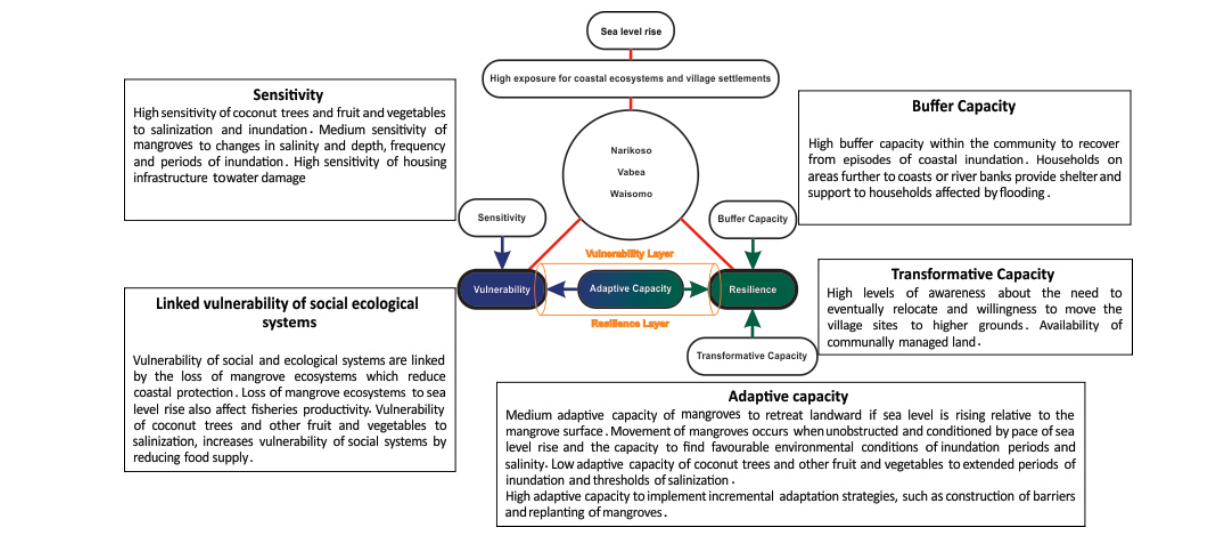
Fig. 5. Drivers of vulnerability and resilience to sea-level rise identified on Ono Island, Fiji. Each component of the model is characterized to identify the different layers of vulnerability and resilience expressed in the systems in relation to sea-level